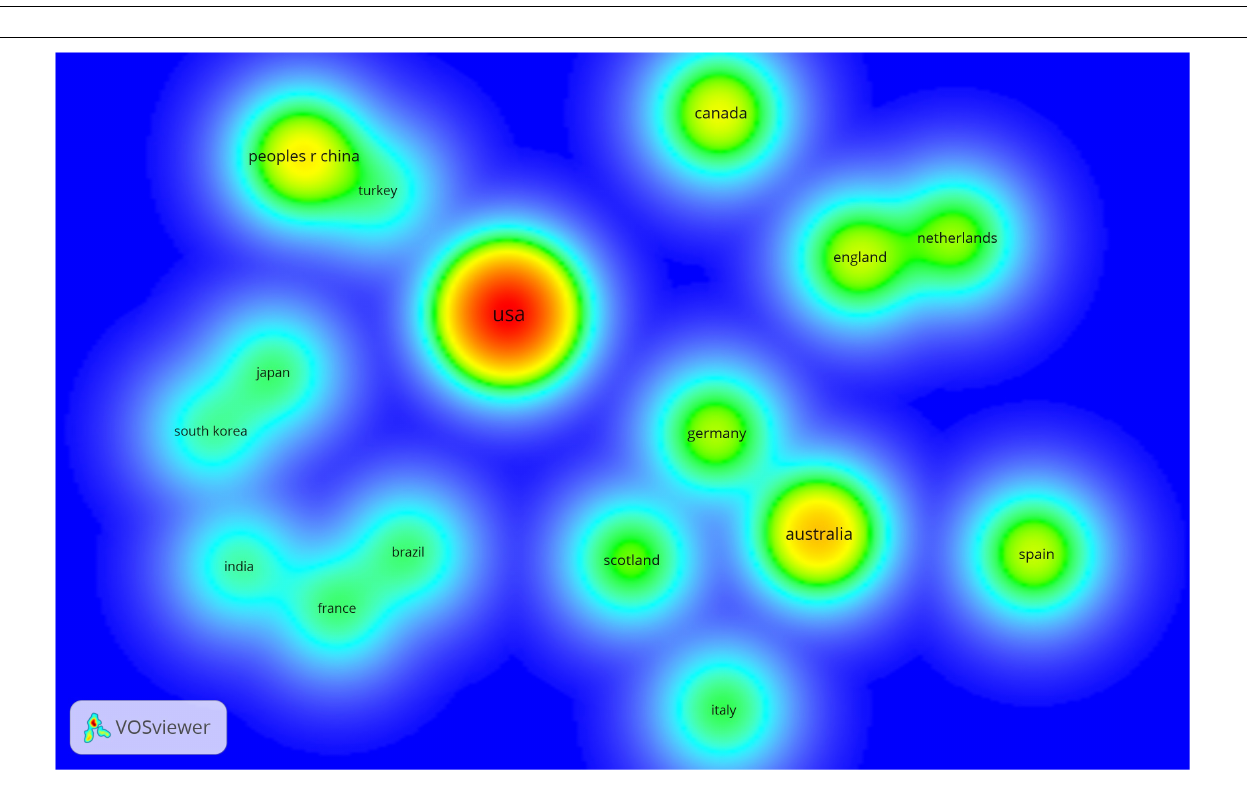
FIGURE 4 | A visualization of co-citation analysis of reference.